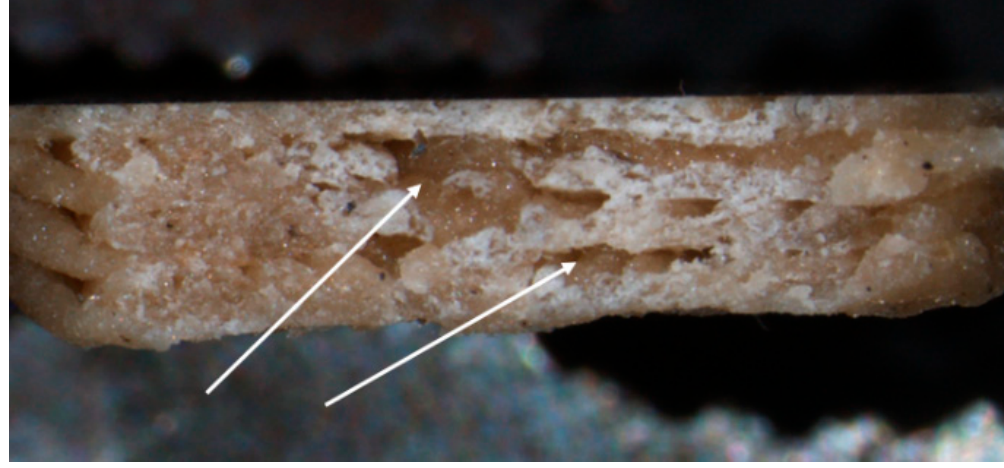
Figure 6. 30 wt % harakeke corresponding fracture surface with arrows depicting voids.